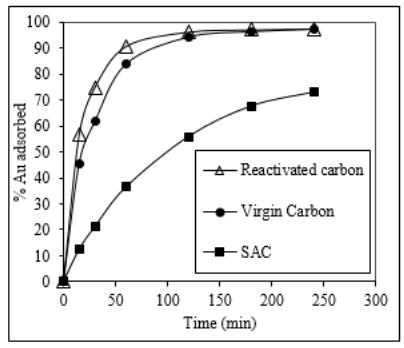
Figure 6. Gold adsorption kinetics (%Au adsorbed as function of time) of virgin carbon, SAC, and reactivated carbon (acid-wash HNO 3 20% v / v at 50 °C and thermal reactivation at 850 °C and 1 h).